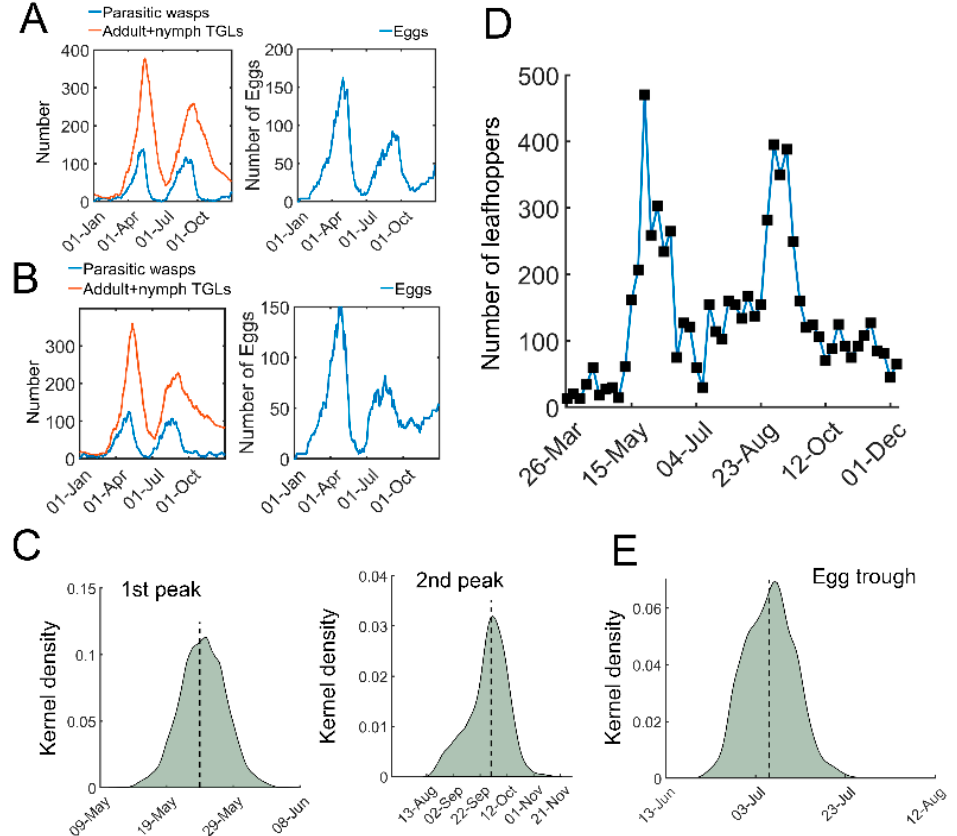
Figure 3. Stochastic simulations of tritrophic interactions. ( A , B ) Two representative simulations using stochastic model. Parasitic wasps (blue) and TGLs (adults + nymphs, red) are shown on the left. The number of eggs is shown on the right. ( C ) Kernel density estimation of distribution of the time for the first (left) and the second outbreak (right). ( D ) A field observation of tea green leafhoppers in a tea garden in 2020 at Yangting Village, Wuheng Town, Yixiu District, Anqing City from Southwest Anhui, China. ( E ) Distribution for the trough time of the eggs. The kernel density estimation was based on 5000 sets of stochastic simulations.